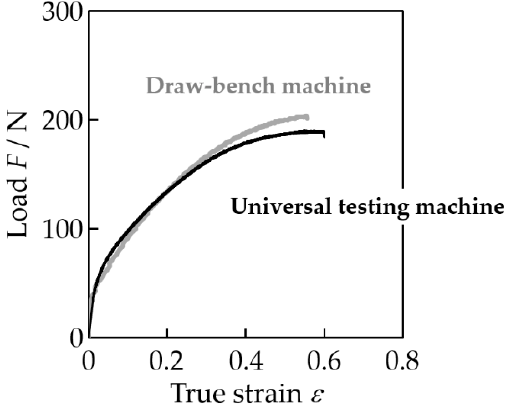
Figure 11. Comparison of the load obtained by the tensile test using the universal testing machine and the draw-bench machine without the die.